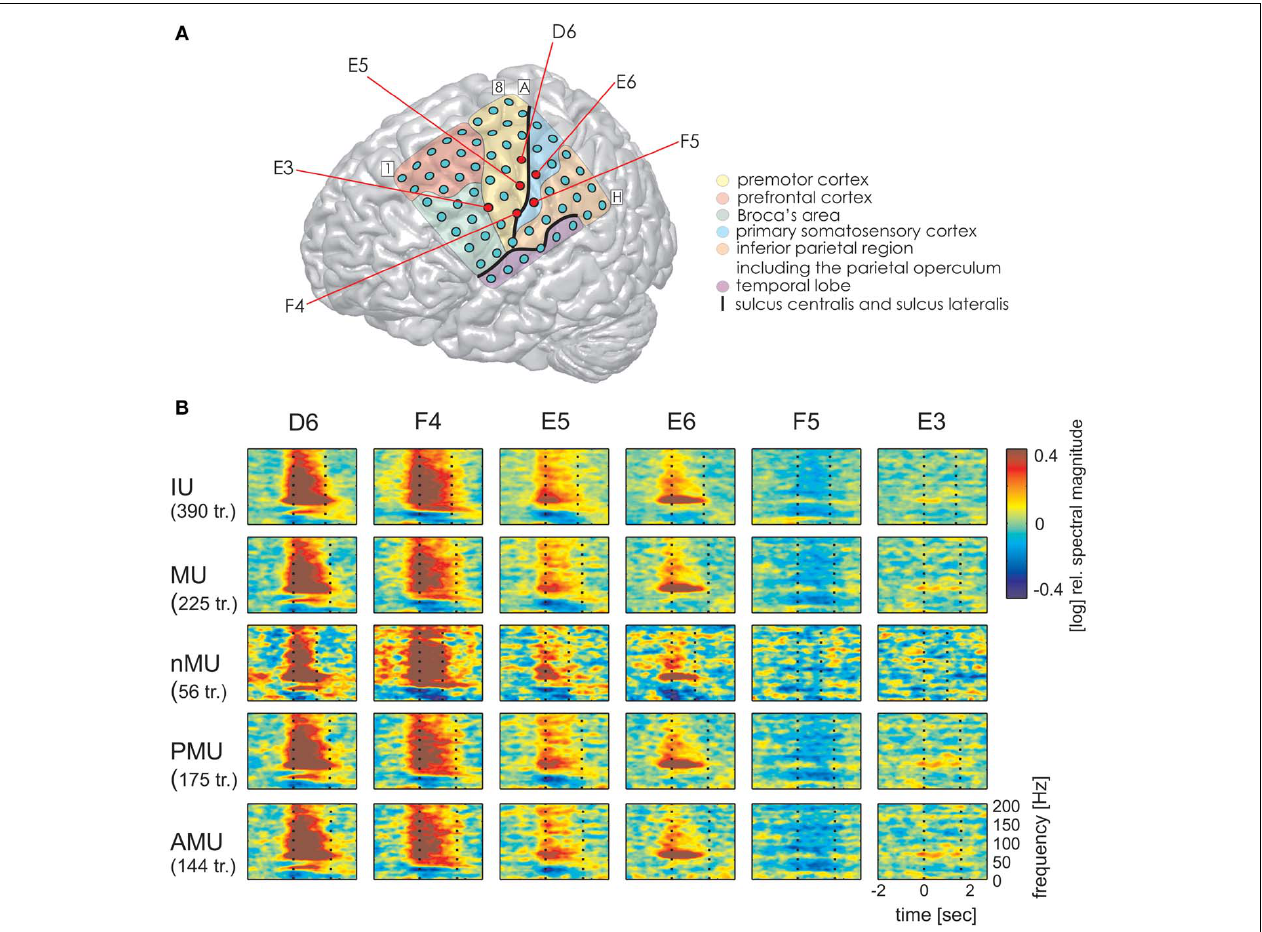
FIGURE 5 | Examples of typical time-resolved spectral magnitude changes underlying different IU categories at ESM-defined mouth motor electrodes (S2). Electrodes marked by red circles in (A) correspond to: electrodes with significant high gamma responses D6, F4, E3 (all IUs together) and electrodes without significant high